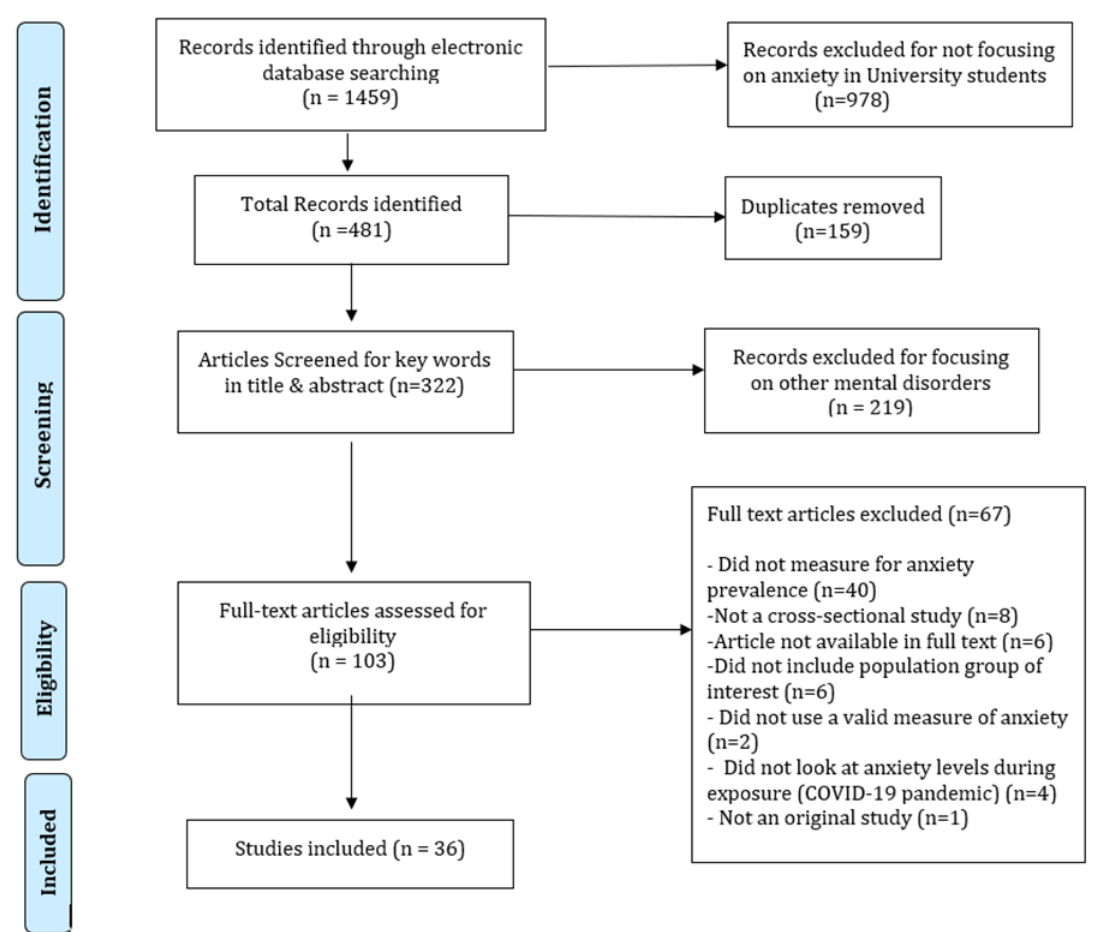
Figure 1. PRISMA flow